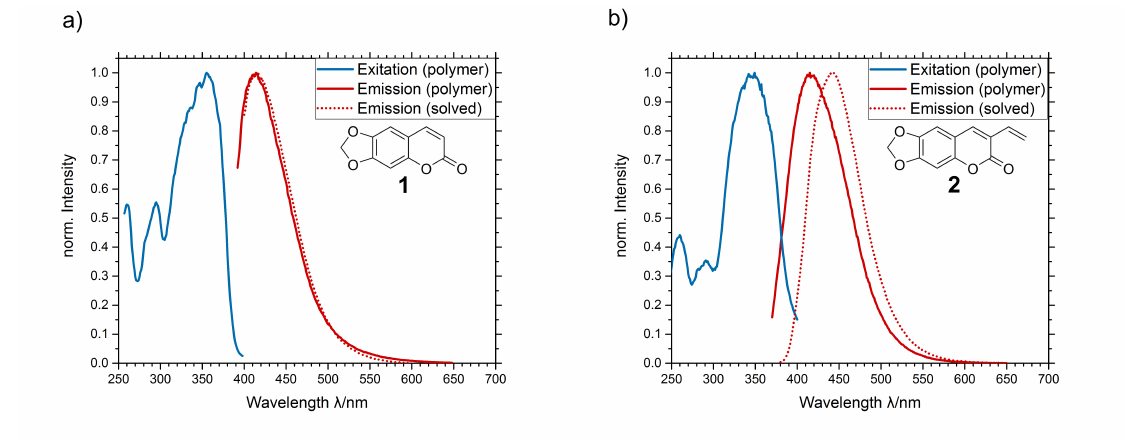
Figure 4. Photoluminescence spectra of ( a ) ayapin and ( b )